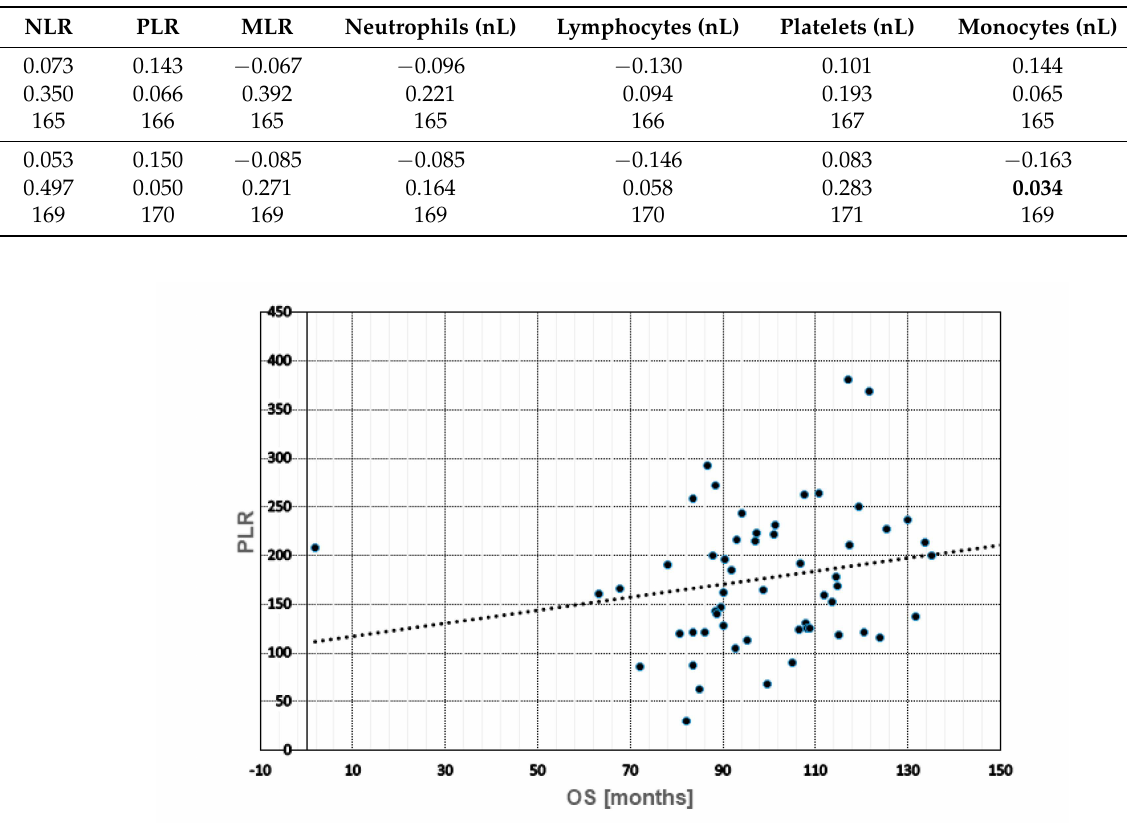
Table 4. Correlation between blood cells, ratios and outcome. MLR: monocyte-to-lymphocyte ratio; NLR: neutrophil-to-lymphocyte ratio; OS: overall survival; PFS: progression-free survival; PLR: